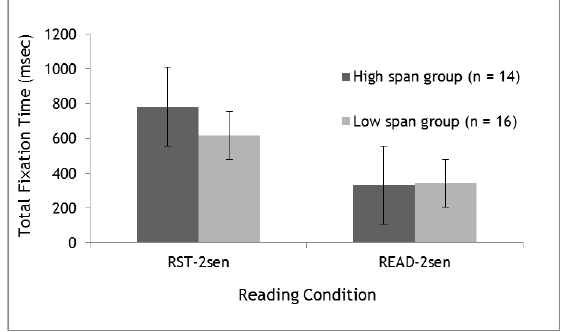
Figure 3 . Total fixation time (s) for the high-span group and low-span group for READ and RST under the two-sentence condition.